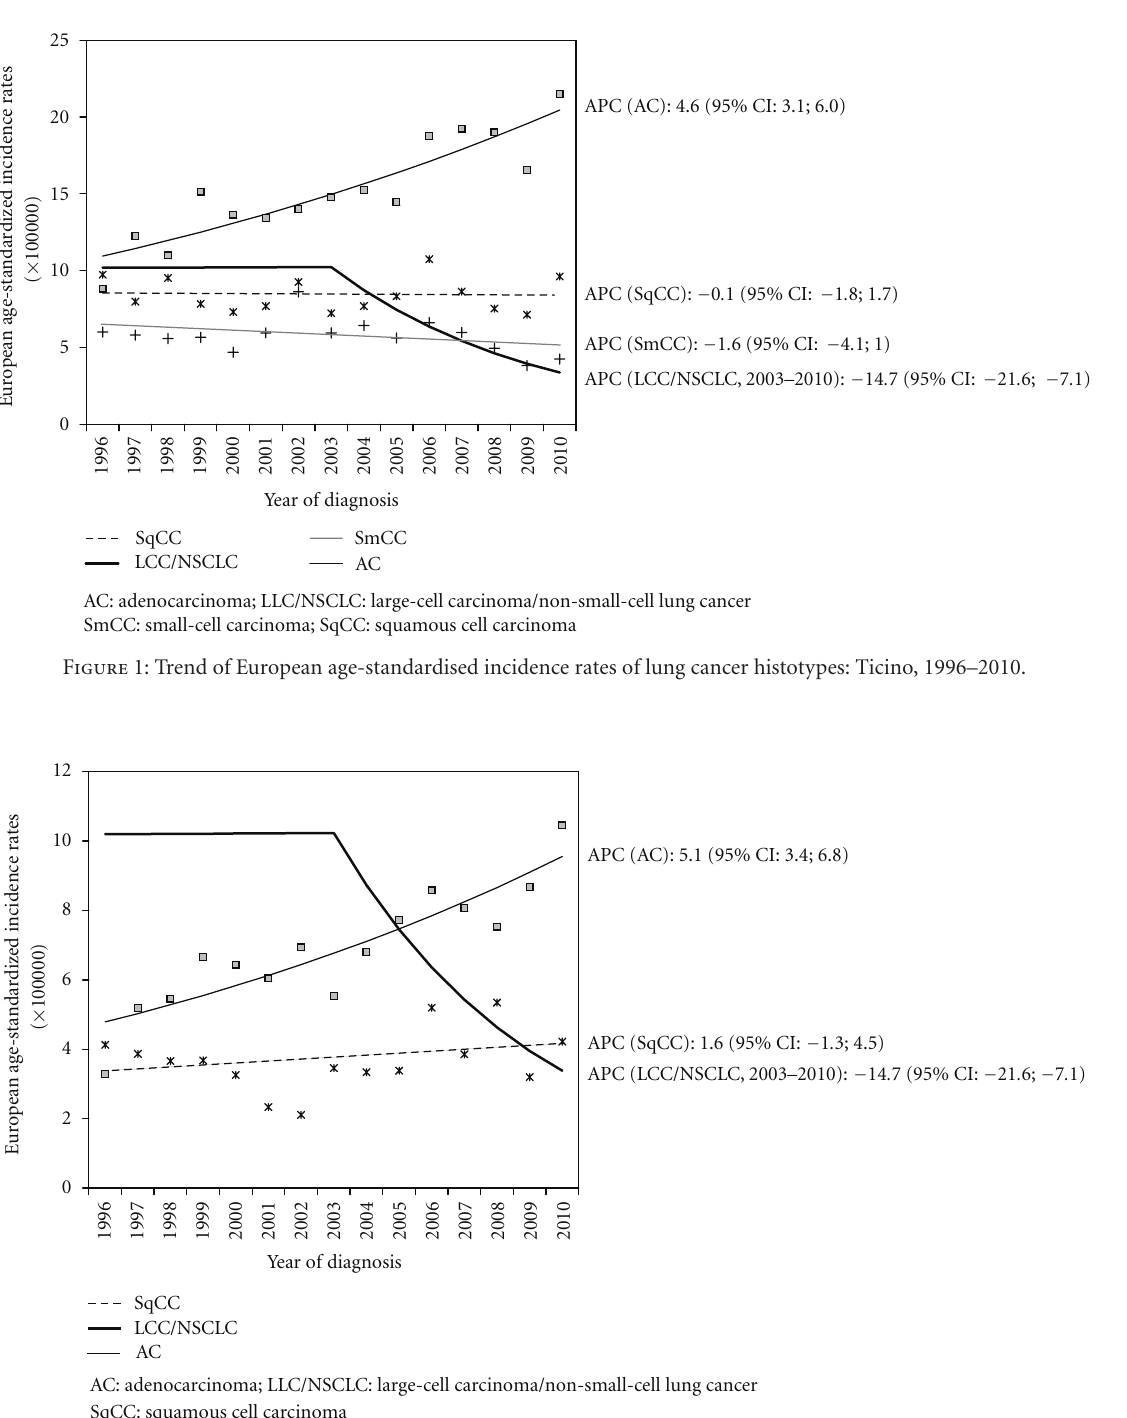
study periods (Table 1). In particular, we observed a higher proportion of AC tumours after 2003 (40.9% in 1996–2003 versus 59.1% in 2004–2010, P < 0 . 0001), corresponding to a percentage increase of 44.5% of the total cases; in contrast, there was a significant decrease in LCC/NSCLC proportion (64.0% in 1996–2003 versus 36.0% in 2004–2010, P <